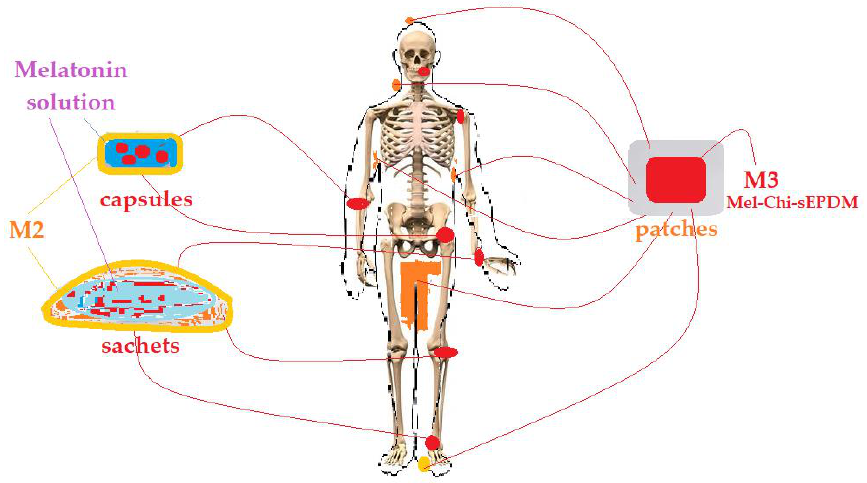
Figure 18. Possible ways to deliver melatonin using chitosan–sEPDM (M2) or melatonin–chitosan–sEPDM (M3) composite membranes.